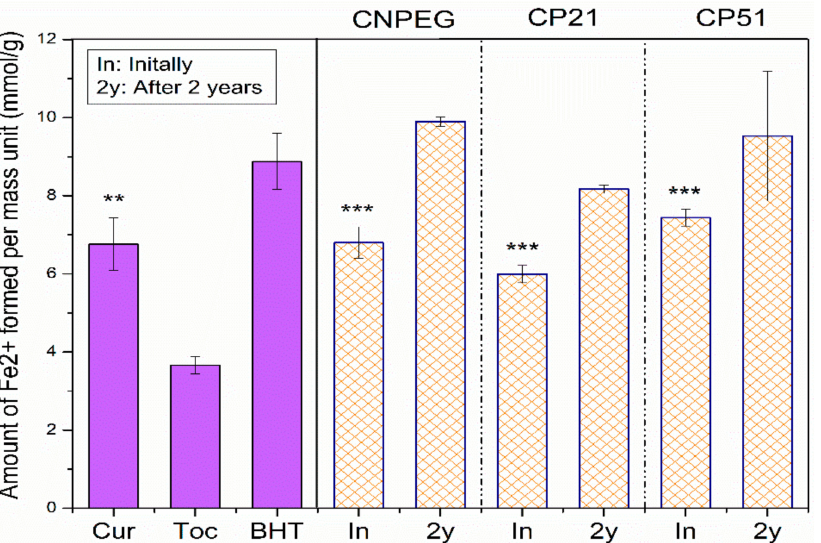
Figure 5. FRAP assay values for antioxidants and curcumin-loaded nanoemulsions: means ± sd ( n = 3); ** and *** p < 0.01; p < 0.001, compared to